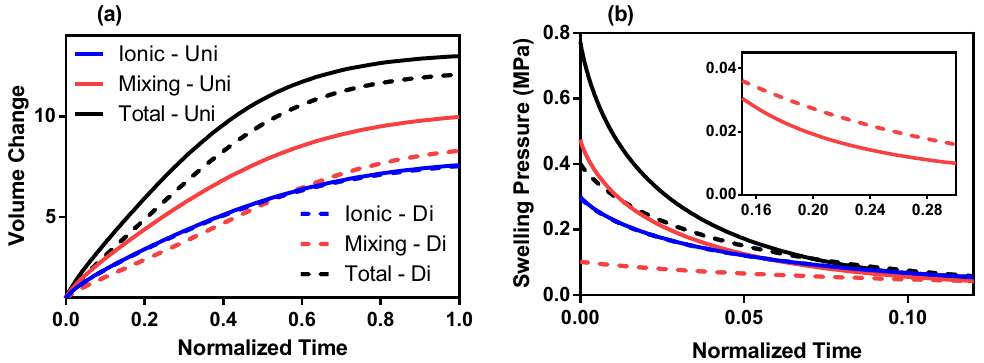
Figure 4. ( a ) Volume change as a function of normalized time (fraction of time to reach equilibrium) of ionic, mixing and total swelling pressures for univalent and divalent solutions. ( b ) Swelling pressures of ionic, mixing and total swelling energies of univalent and divalent solutions as a function of normalized time. φ s ,0 = 20%. Inlay: Mixing energy swelling pressure (MPa) between 0.15 and 0.3 of normalized